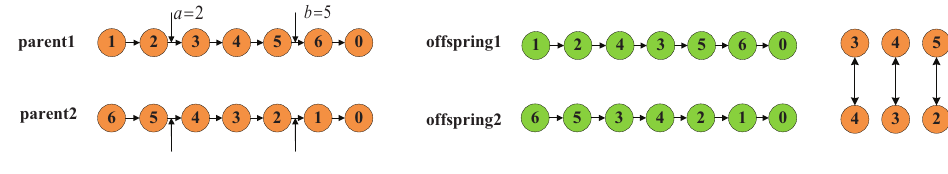
Figure 5. The mutation process in GA-LNS